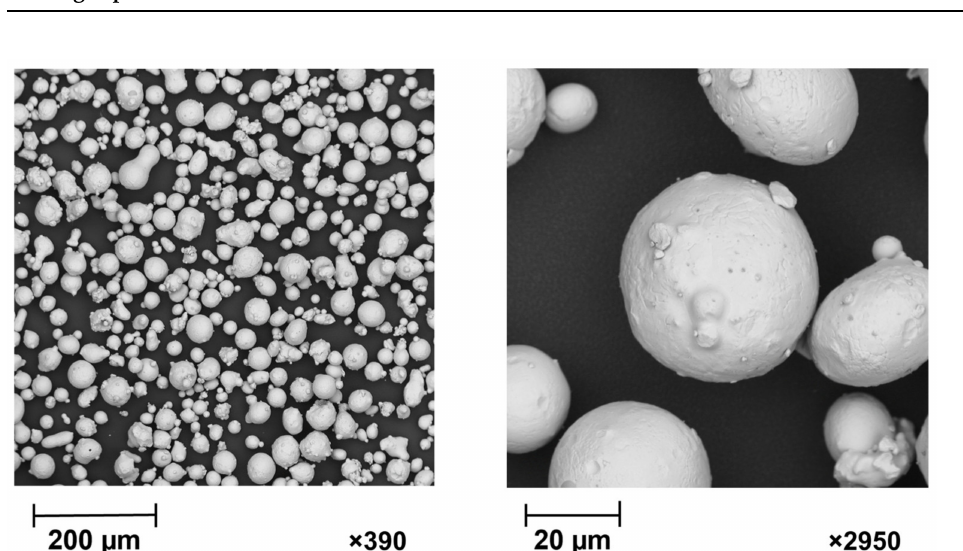
Figure 4. SEM image of 316L austenitic stainless steel powder MetcoAddTM 316L-A. The image shows the spherical morphology of the powder by magnitude, respectively, 390 and 2950, produced by the gas atomization